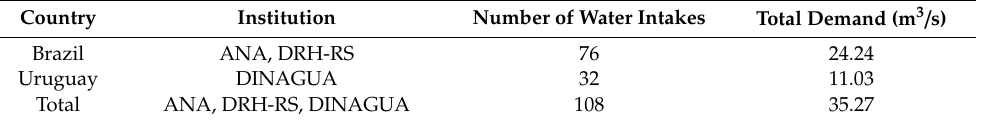
Table 1. Number and total demand for water intakes in the Cuareim / Quara í basin.